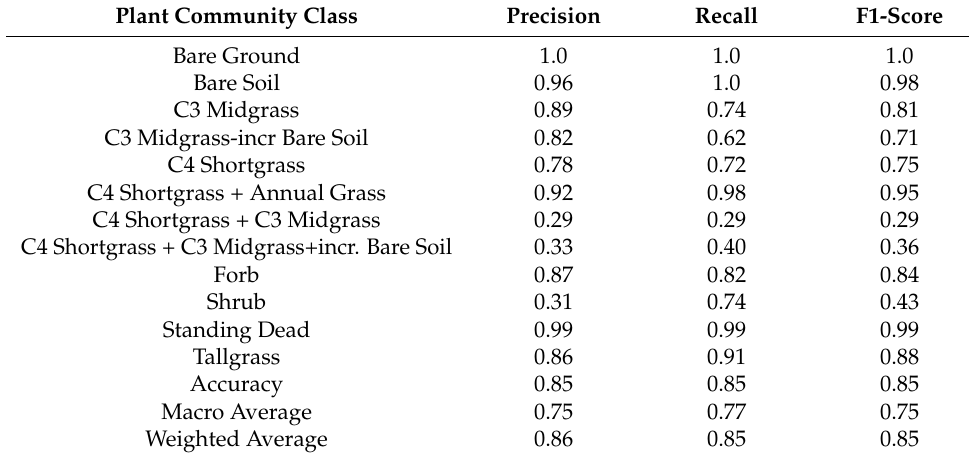
Figure 6. Mapped results of the classification pipeline showing the plant community classes for 2013 ( A ) and 2017 ( B ). To characterize plant community shifts between 2013 and 2017, we visualized the pixel ‐ level changes using a Sankey Diagram (Figure 7). Within the plant community